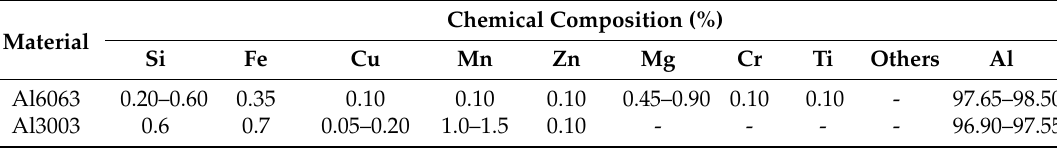
Table 1. General chemical composition of the components Al6063 and Al3003 [14,15].